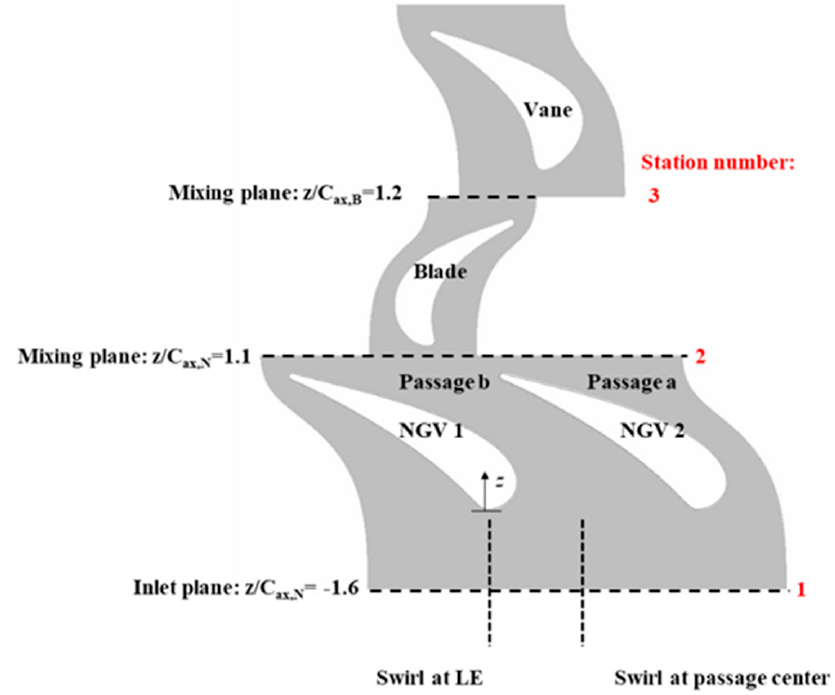
Figure 5. Swirl center location and measurement plane.